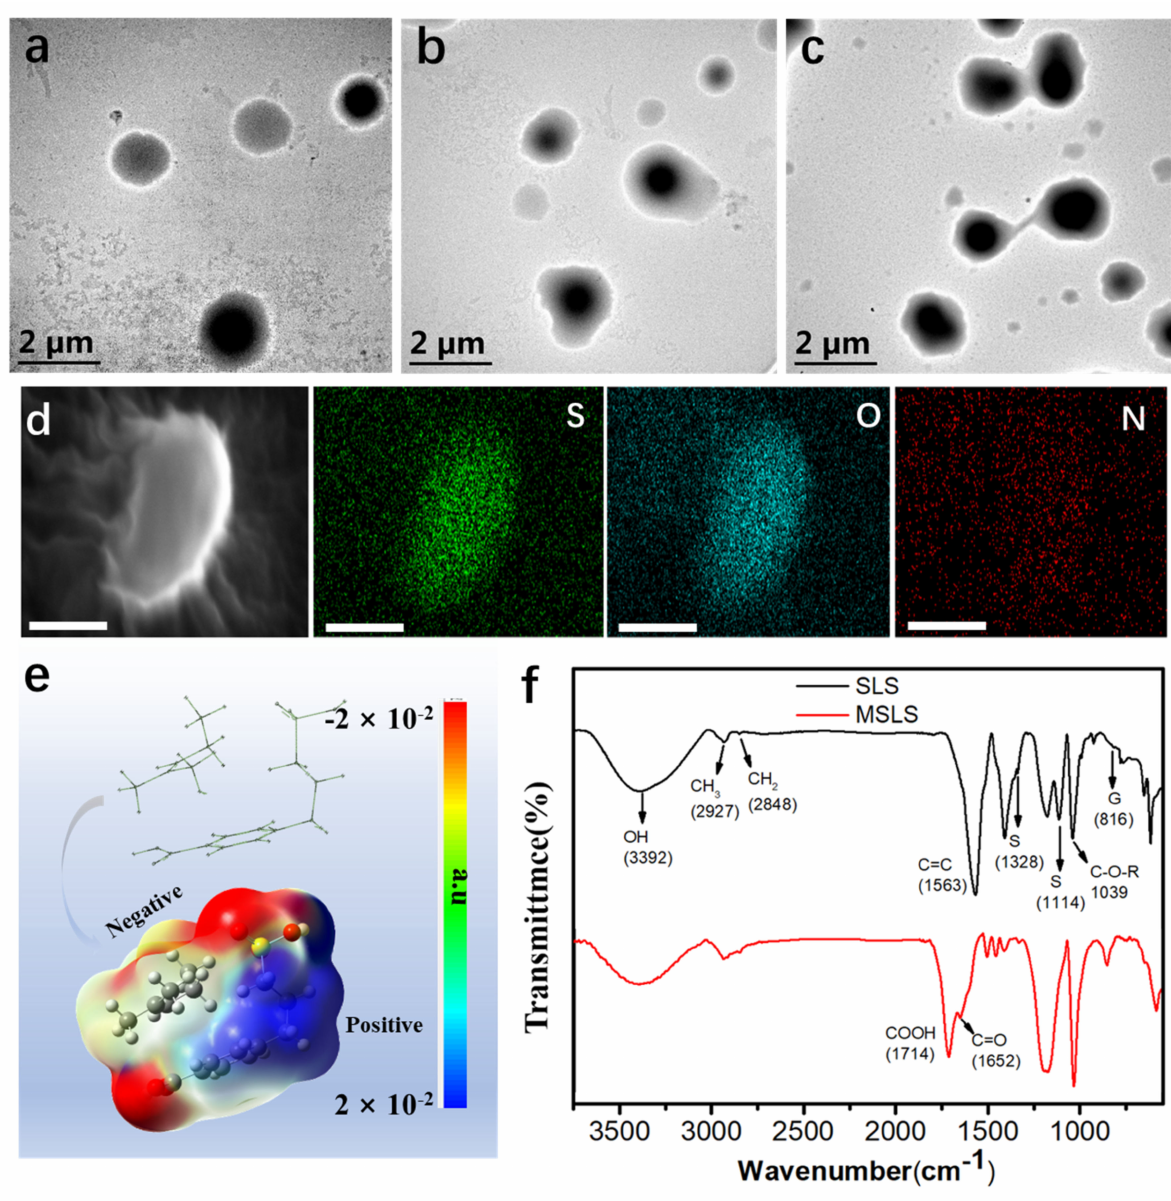
Figure 2. TEM images of simulated pre-vulcanized NRL. ( a ) NRL, ( b ) MSLS/NRL, ( c ) MSLS- PAE/NRL, ( d ) SEM image of element distribution (S, O, and N) of MSLS-PAE/NRL particles (the scales bar is 2 µ m), ( e ) molecular electrostatic potential image, and ( f ) RTIR spectra of sodium lignosulfonate (SLS) and